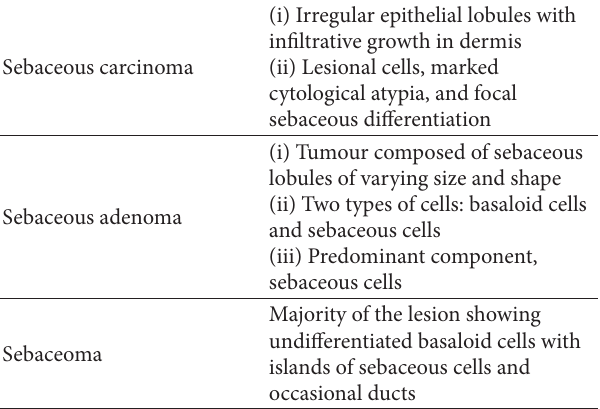
Table 8: Salient histopathological features of sebaceous tumours.